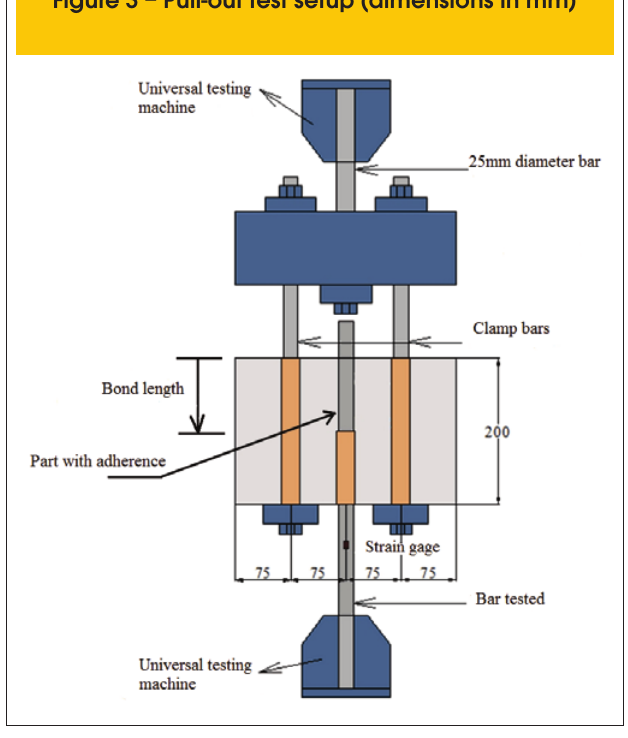
Figure 4 – Test specimen preparation